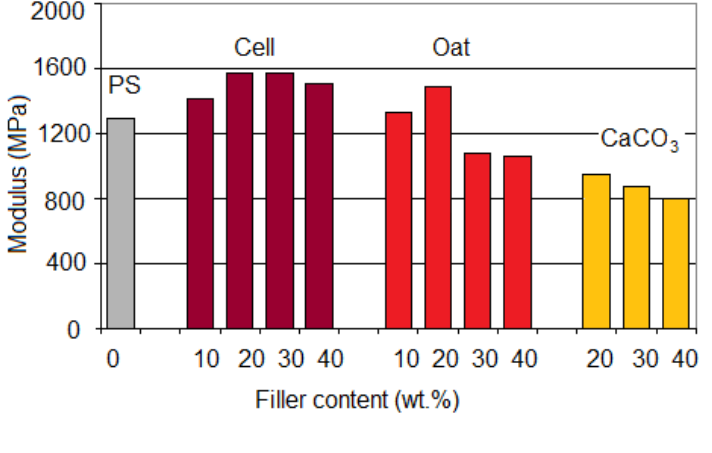
composites vs. filler 3